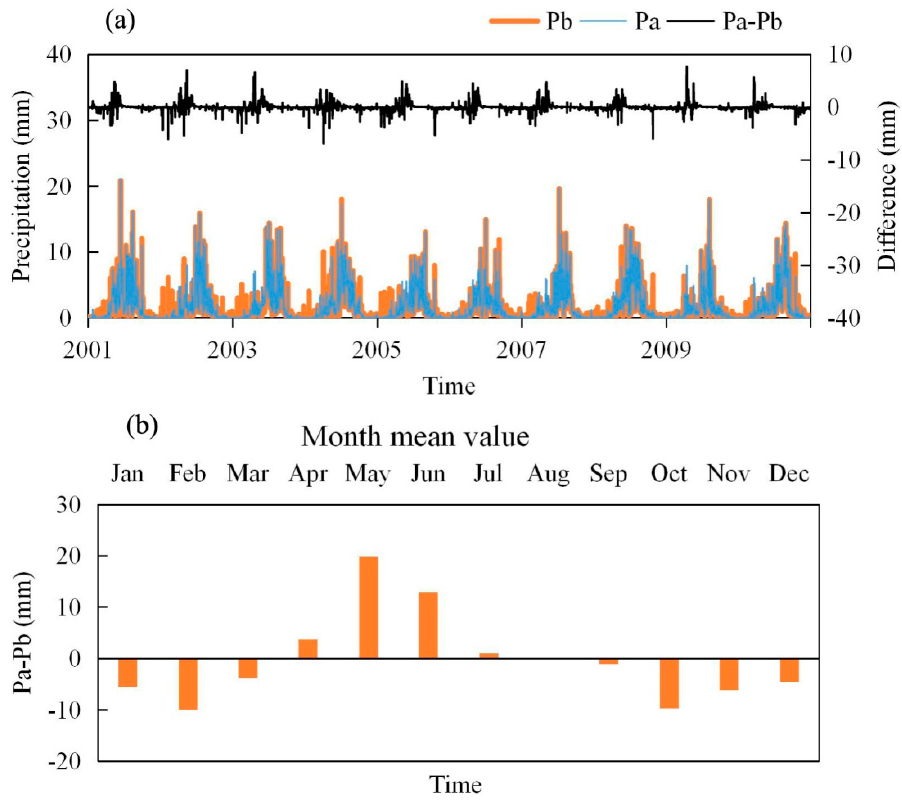
Figure 11. The average daily precipitation data before (Pb, including snowfall and rainfall) and after (Pa, including snowmelt and rainfall), considering the process of snow melting by using the degree-day model ( a ) and the multi-year monthly mean value of (Pa-Pb) ( b ).